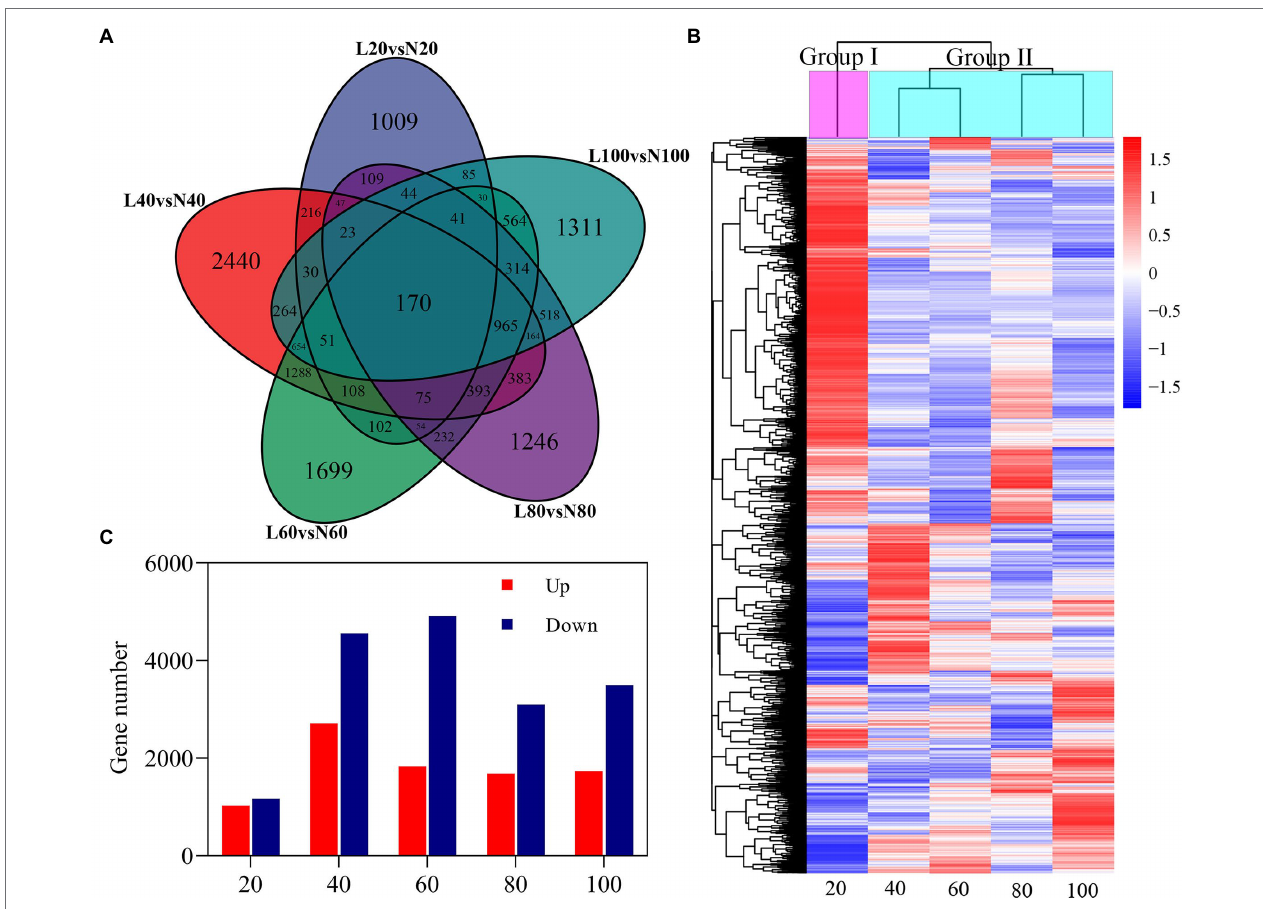
FIGURE 5 | Differentially expressed genes (DEGs) in roots in response to nitrogen stress. (A) Venn diagrams of five comparisons (20, Low N 20 vs. Normal N 20; 40, Low N 40 vs. Normal N 40; 60, Low N 60 vs. Normal N 60; 80, Low N 80 vs. Normal N 80; and 100, Low N 100 vs. Normal N 100). DEGs at different stages, (B) up- and downregulated genes of five comparisons at different stages, and (C) hierarchy clustering of five comparisons of DEGs. The rows in the heat map represent genes, and the columns indicate comparisons between low nitrogen and normal nitrogen. The colors in the heat map indicate the values of log 2 fold